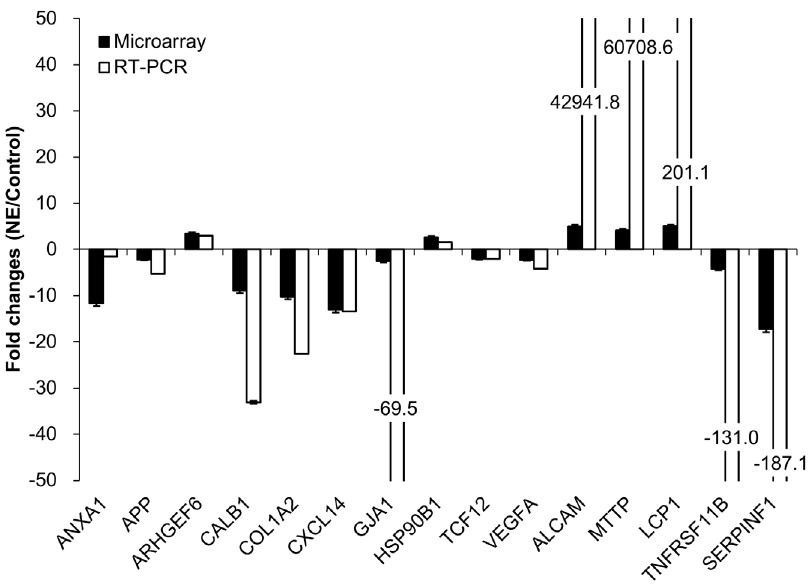
Fig. 3. Comparison of the fold changes in the expression levels of 15 immune-related gene transcripts in intestinal IELs of C. perfringens / E. maxima co-infected Ross chickens (NE) compared with uninfected controls (Control). Transcript levels were analyzed by microarray hybridization and qRT-PCR in both groups. Each bar represents the mean ¡ SD value of the fold change in the transcript level (n 5 3). ANXA1, Annexin A1; APP, Amyloid precursor protein; ARHGEF6, Rho guanine nucleotide exchange factor 6; CALB1, Calbindin 1; COL1A2, Collagen, type 1, alpha 2; CXCL14, Chemokine (C-X-C motif) ligand 14; GJA1, Gap junction alpha 1; HSP90B1, Heat shock protein 90kDa beta 1; VEGFA, Vascular endothelial growth factor A; ALCAM, Activated leukocyte cell adhesion molecule; MTTP, Microsomal triglyceride transfer protein; LCP1, Lymphocyte cytosolic protein 1; TNFSF11B, Tumor necrosis factor superfamily 11; SERPINE1, Serpin peptidase inhibitor, clade